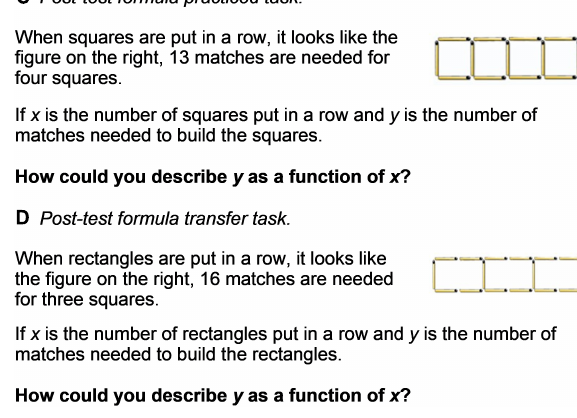
FIGURE 2 | Examples of test tasks and how they were presented to the students on their laptop screen. (A,C) Practiced test tasks and (B,D) transfer test